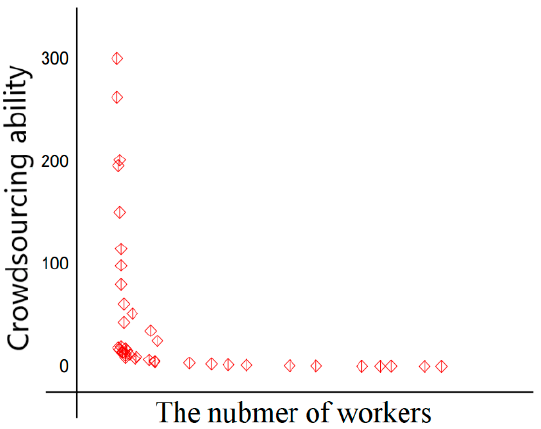
Figure 3. The distribution of workers’ crowdsourcing capacities.